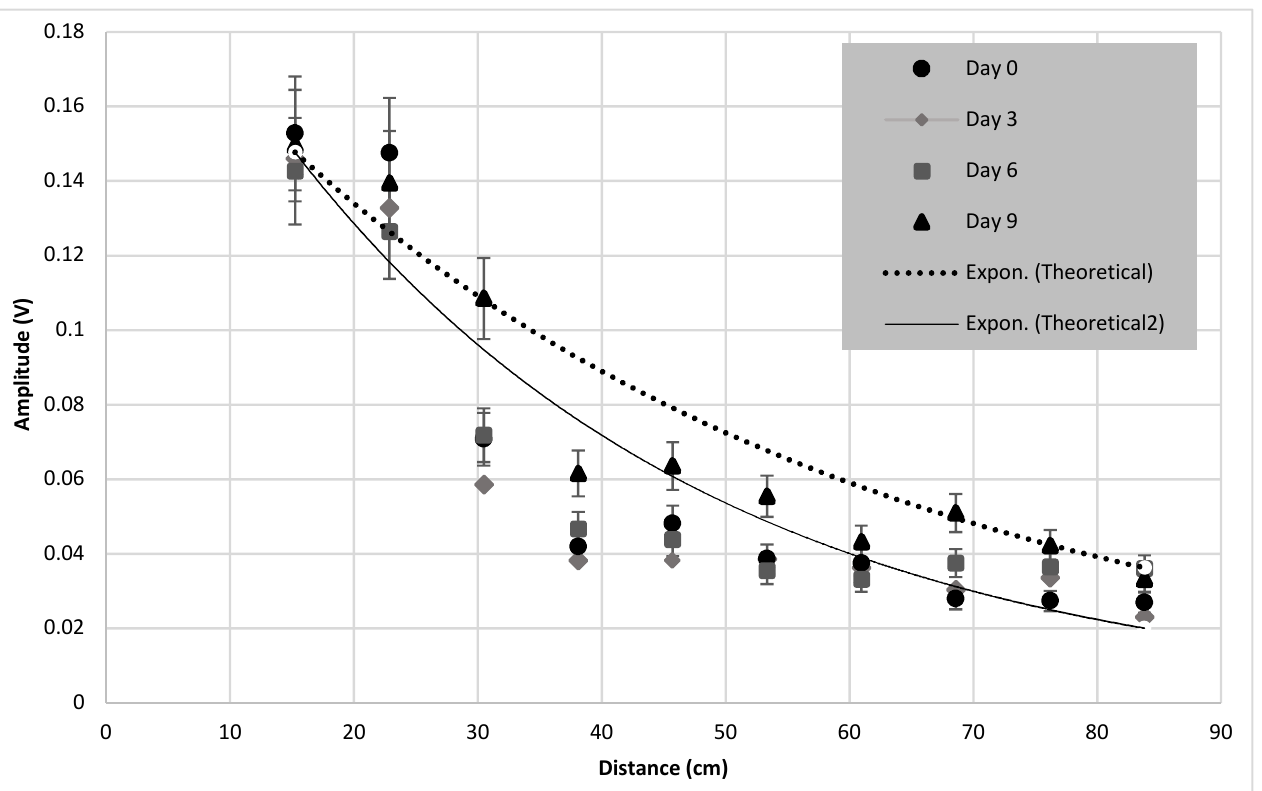
Figure 4. ( a ) Extracted core from the concrete specimen; ( b ) Concrete sample in pulverized form.